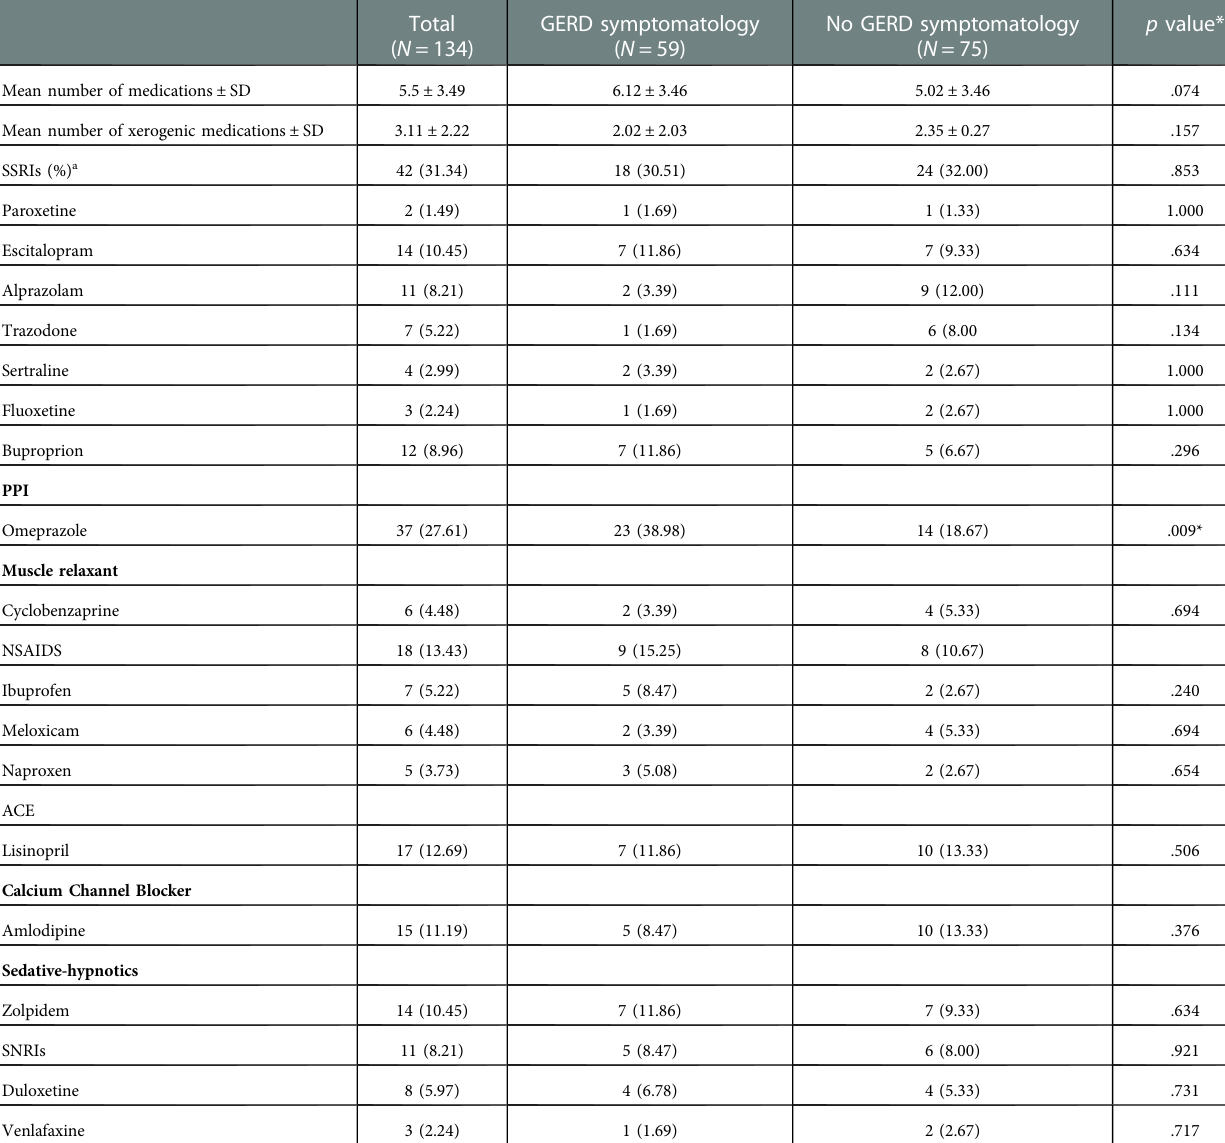
TABLE 2 Number and type of medication intake in the study population and differences between participants with and without GERD